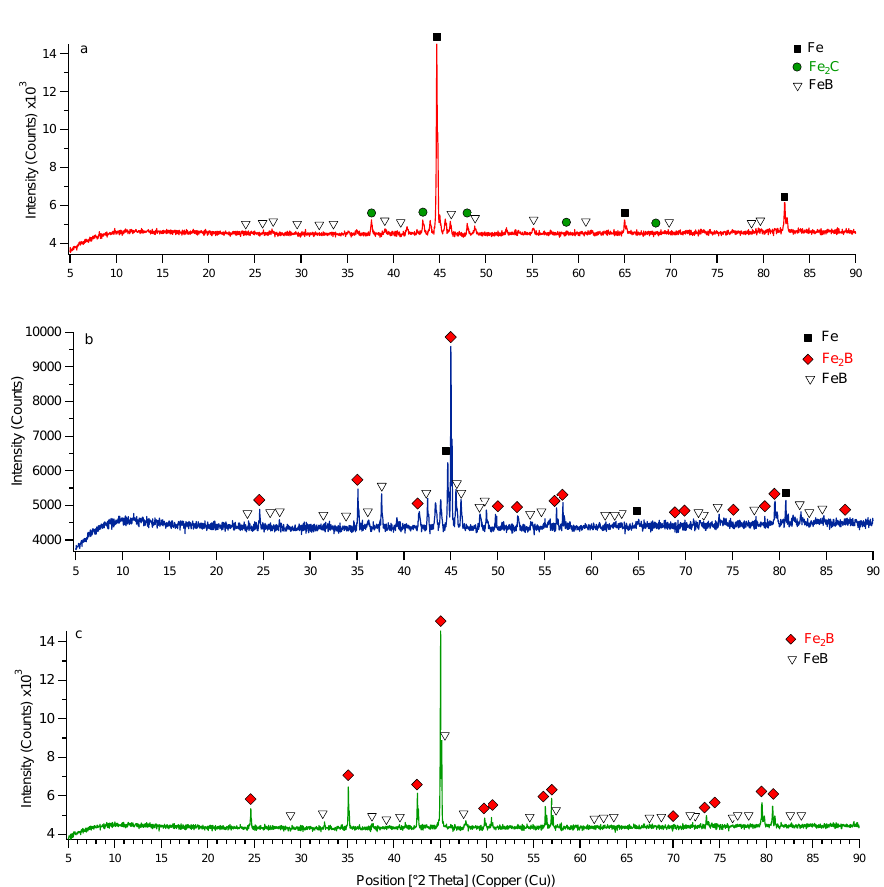
Figure 7. X-ray Diffraction (XRD) spectrum of the 60 min sintered ( a ) Fe + 10 vol.% B 4 C; ( b ) Fe + 20 vol.% B 4 C; ( c ) Fe + 30 vol.% B 4 C composites.